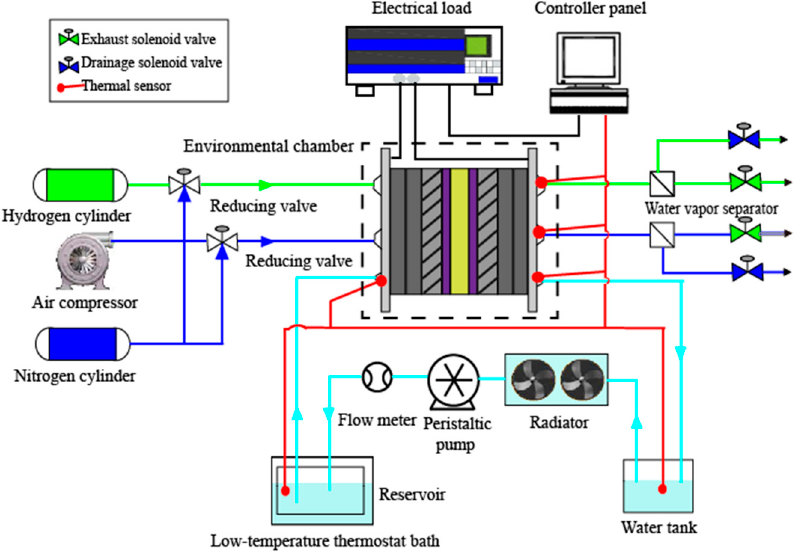
Figure 2. The schematic of the PEMFC platform for cold start with a thermal management system.